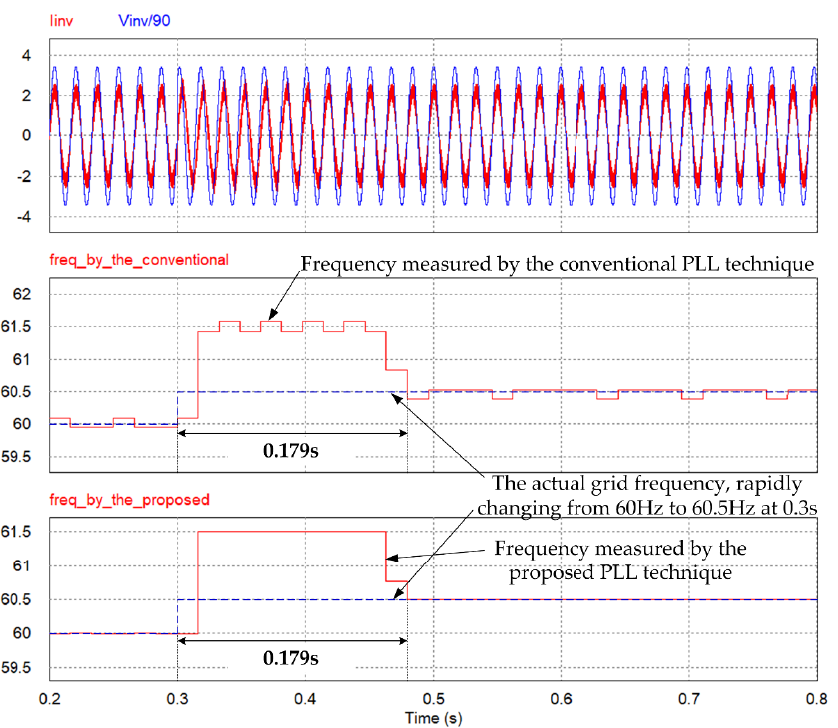
Figure 11. Key waveforms of the PV inverter when the grid voltage frequency is rapidly changing from 60 Hz to 60.5 Hz.